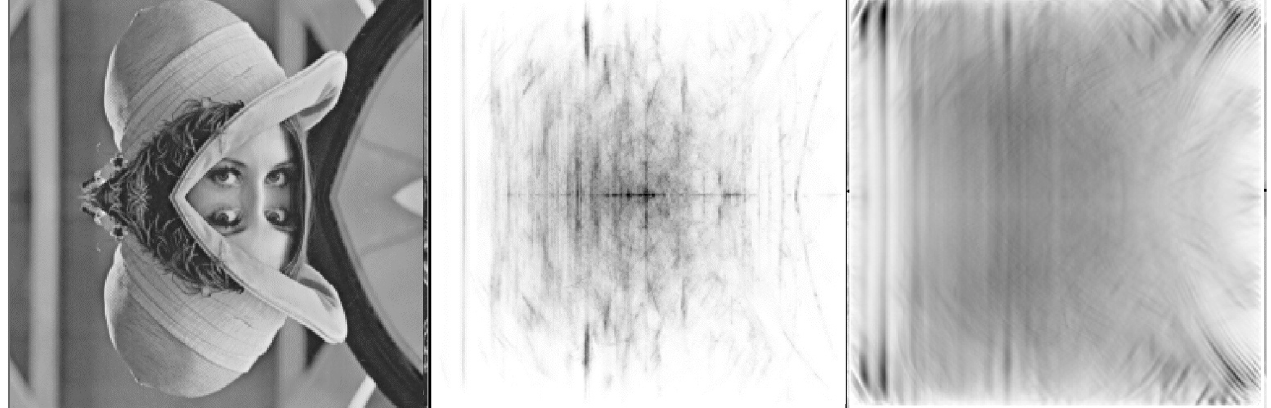
Figure 6. Comparison of large field symmetry detection. The original is on the left, the and the symmetry maps produced by the IGHM and Reisfeld’s methods respectively in the middle and the right